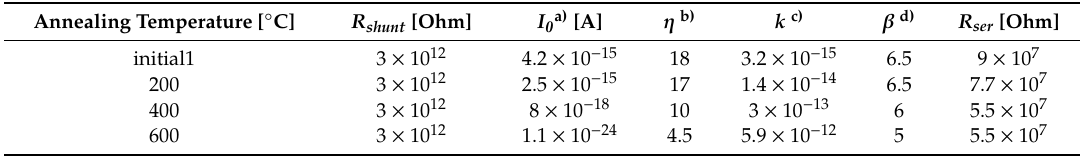
Table 1. The parameters extracted from the fitting of the forward bias I – V characteristics for the annealed single nanorod n -ZnO / p -GaN heterojunctions on the FIB-patterned substrate. Annealing Temperature [ ◦